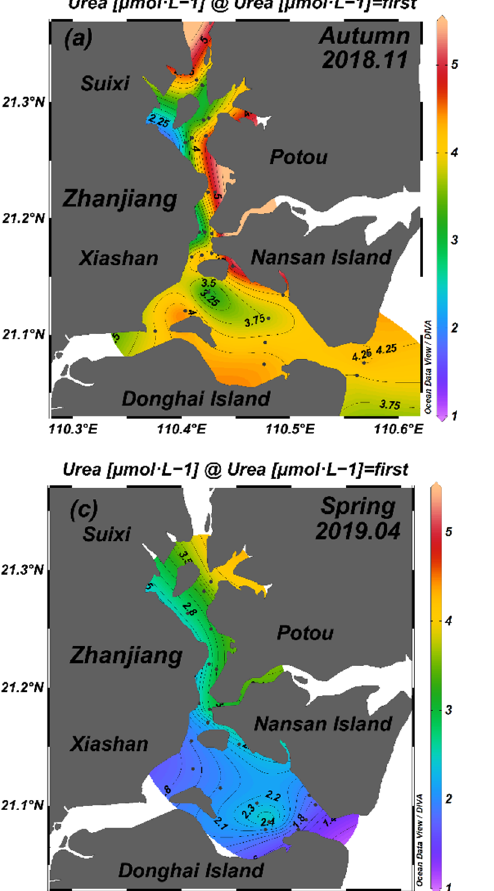
Figure 3. Seasonal changes in urea illustrated using a box diagram for coastal water of the ZJB (data were from November 2018 to June 2019). (The lines and squares, lower and upper edges, and lines and crosses in- or outside the boxes represent median and mean values, 25th and 75th, <99th and >1th, and minimum and maximum values of all data, respectively; Symbols see Figure 3). Table 2. Seasonal urea concentration: mean, maximum, and minimum values in ZJB. Month Mean ± SD ( μ mol·L − 1 )